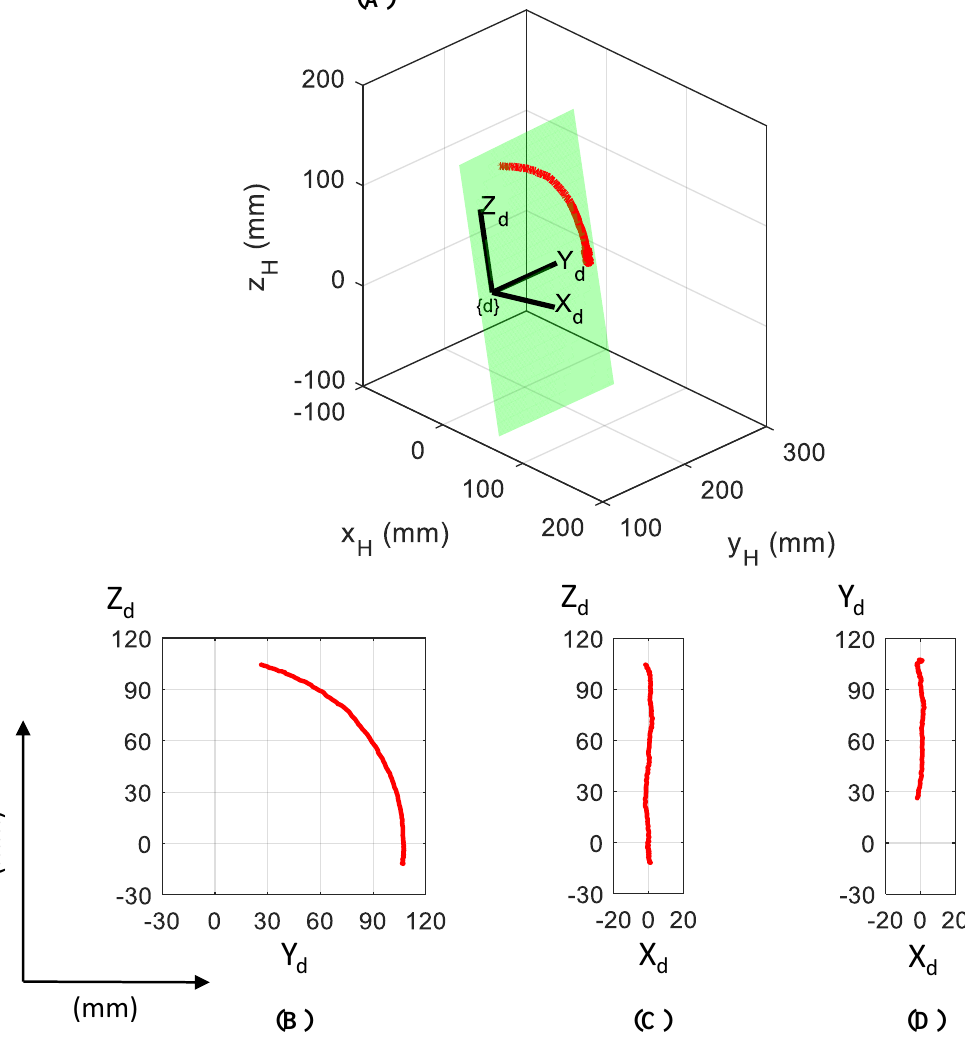
Figure 3. Baseline P Ulna trajectory (red line) in 0–90 ◦ elbow flexion–extension referred to the humerus coordinate system ( A ) and in the deflection reference system planes Y d Z d , X d Z d , X d Y d ( B ), ( C ), and ( D ). Green plane represents the regression plane.